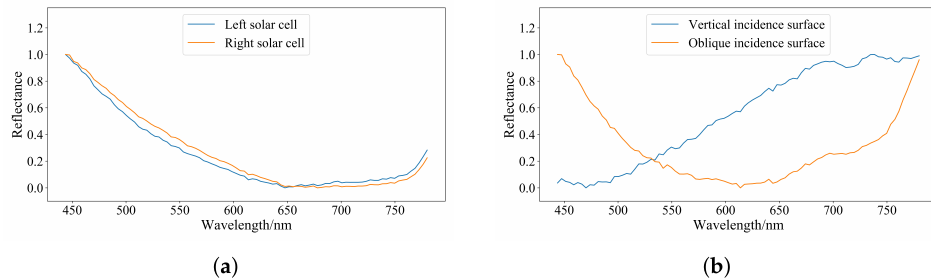
Figure 22. Spectral data distributions of high spatial resolution and positive Y-axis incidence: ( a ) left and right solar cells; ( b ) gold mylar on different surfaces.